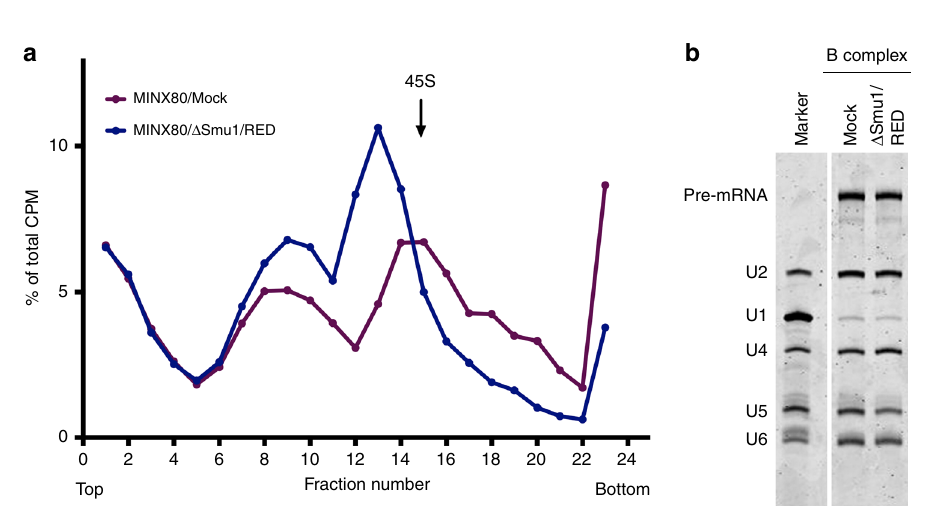
Fig. 5 Characterisation of B complexes that accumulate in the absence of Smu1 and RED. a Glycerol gradient sedimentation pro fi le of spliceosomal complexes assembled after 8 min on MINX80 in mock-depleted or Smu1/RED-depleted extract. The amount of the 32 P-pre-mRNA in each gradient fraction was determined by Cherenkov counting. b RNA composition of B complexes assembled on MINX80 in mock- or Smu1/RED-depleted extract. Wildtype or Δ Smu1/RED spliceosomal complexes peaking in gradient fractions 14 – 16 or 12 – 14, respectively, were subjected to MS2 af fi nity puri fi cation, and the extracted RNA was analysed by denaturing PAGE followed by SYBR gold staining. The position of the pre-mRNA and UsnRNAs is shown on the left. Source data are provided as a Source Data fi